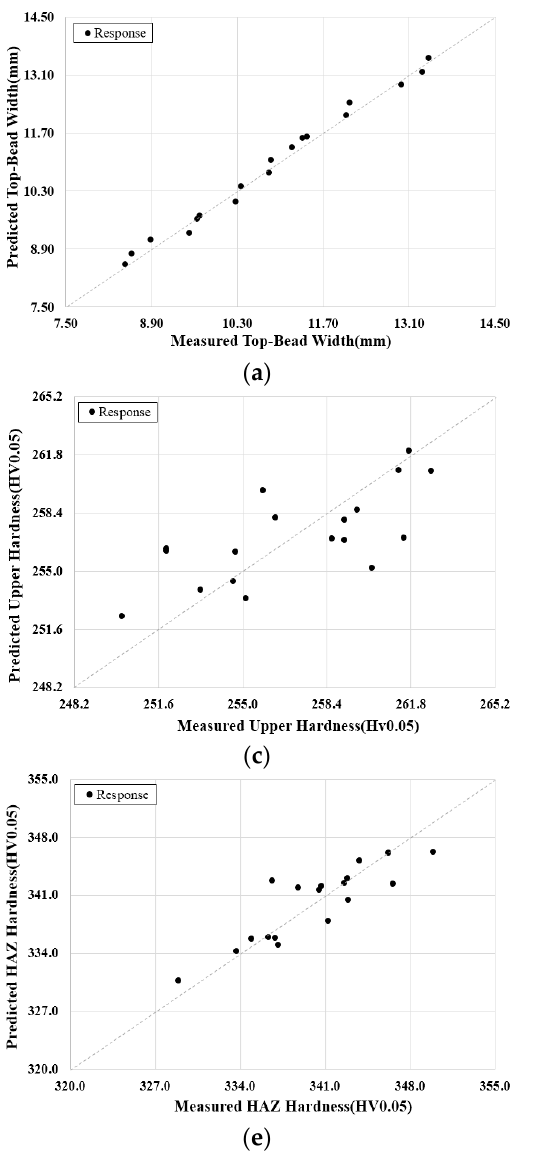
14 of 18 Table 11. Analysis variance tests for predicted model for welding factors. Design Parameter